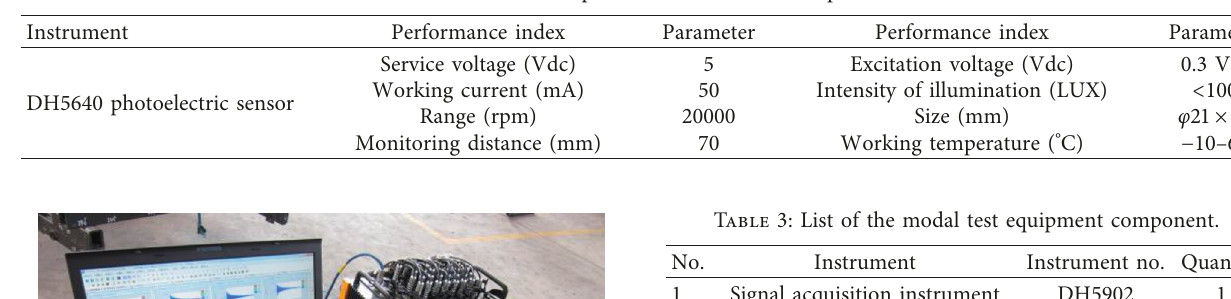
Table 2: Performance index and parameter of the DH5640 photoelectric sensor.